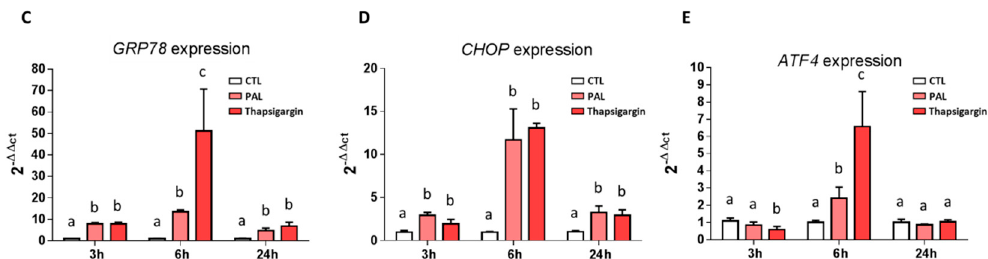
Figure 2. E ff ects of palmitic acid on endoplasmic reticulum stress in LS174T cells. Cells were treated for 3, 6, or 24 h with PAL (300 µ M) or thapsigargin (200 nM) as a strong inducer of ER stress. BSA was used as the control. Representative western blots for ATF4 and CHOP are shown for PAL ( A ) and thapsigargin ( B ) treatments. mRNA expressions of UPR genes GRP78 ( C ), CHOP ( D ), and ATF4 ( E ) in LS174T were measured by quantitative RT-PCR, expressed relatively to CTL and normalized to actin. Data are represented as the mean ± SEM of three independent experiments. Di ff erences were analyzed by Tukey’s multiple comparison test. Bars assigned di ff erent superscript letters (a, b, c) were statistically di ff erent at p < 0.05. ns: non-significant; ATF4: activating transcription factor 4; CHOP: CCAAT-enhancer-binding protein homologous protein; CTL: control bovine serum albumin (BSA); ER: endoplasmic reticulum; GRP78: glucose-related protein 78 kDa; PAL: palmitic acid.